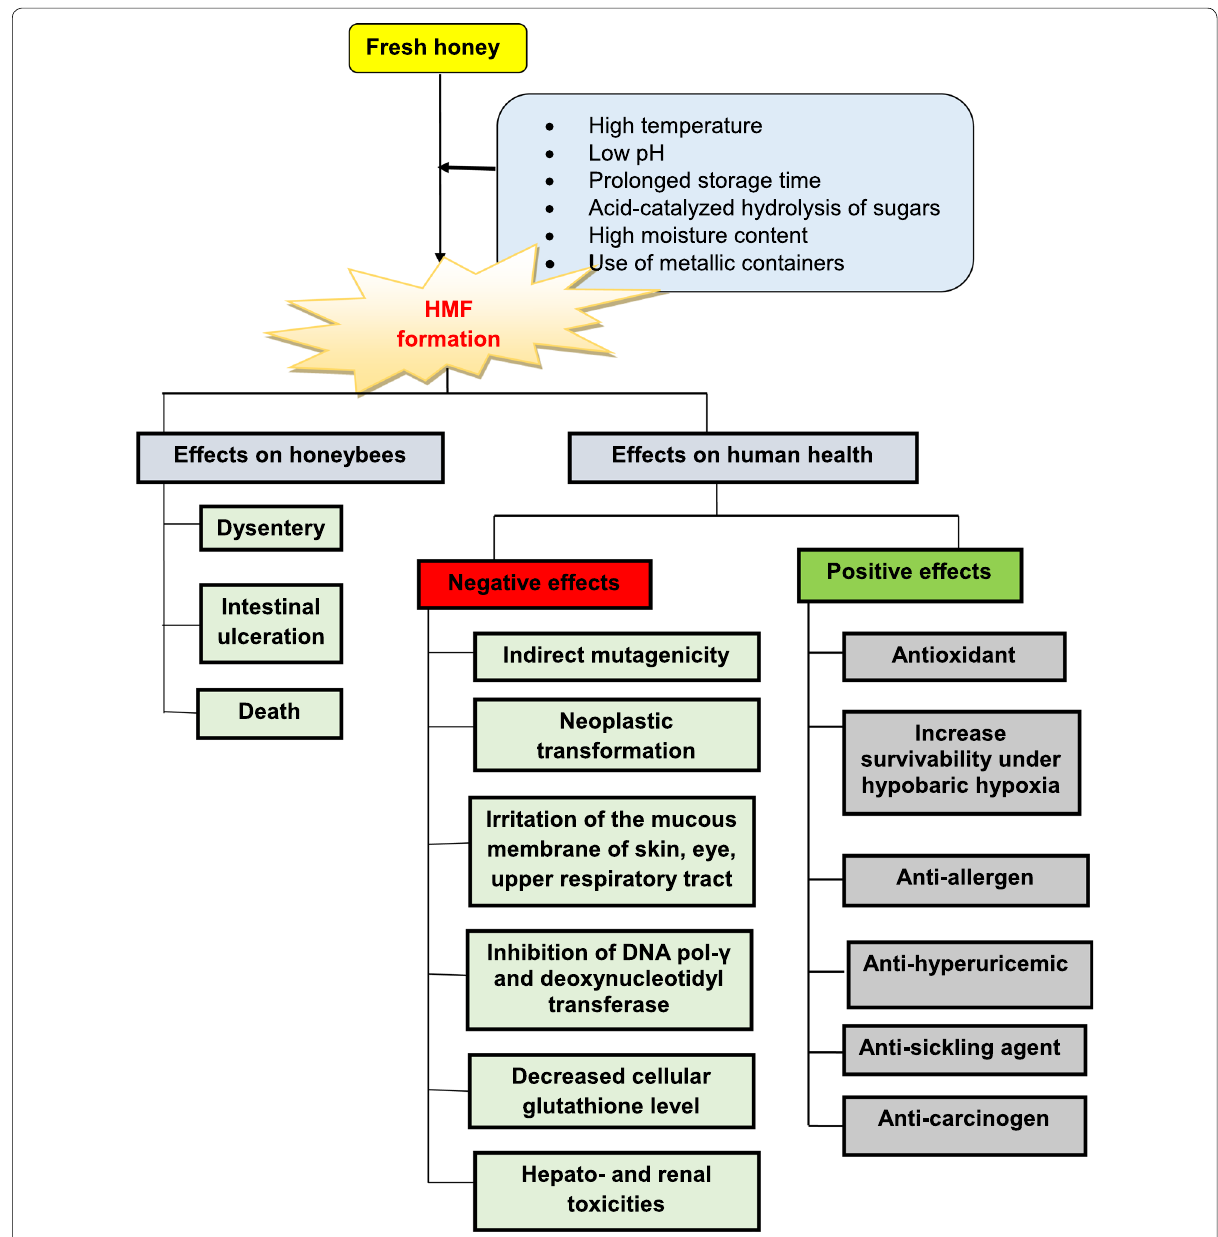
Fig. 3 HMF effects on honey bee and human